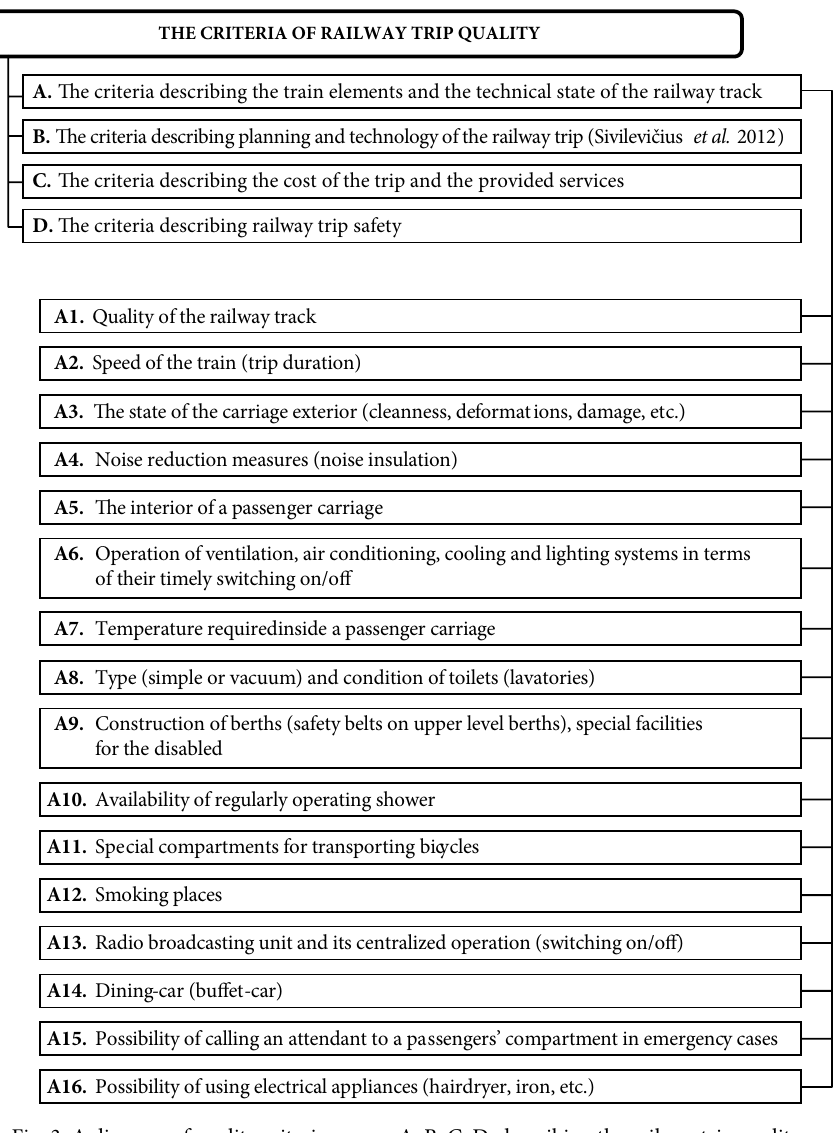
Fig. 3. A diagram of quality criteria groups A, B, C, D, describing the railway trip